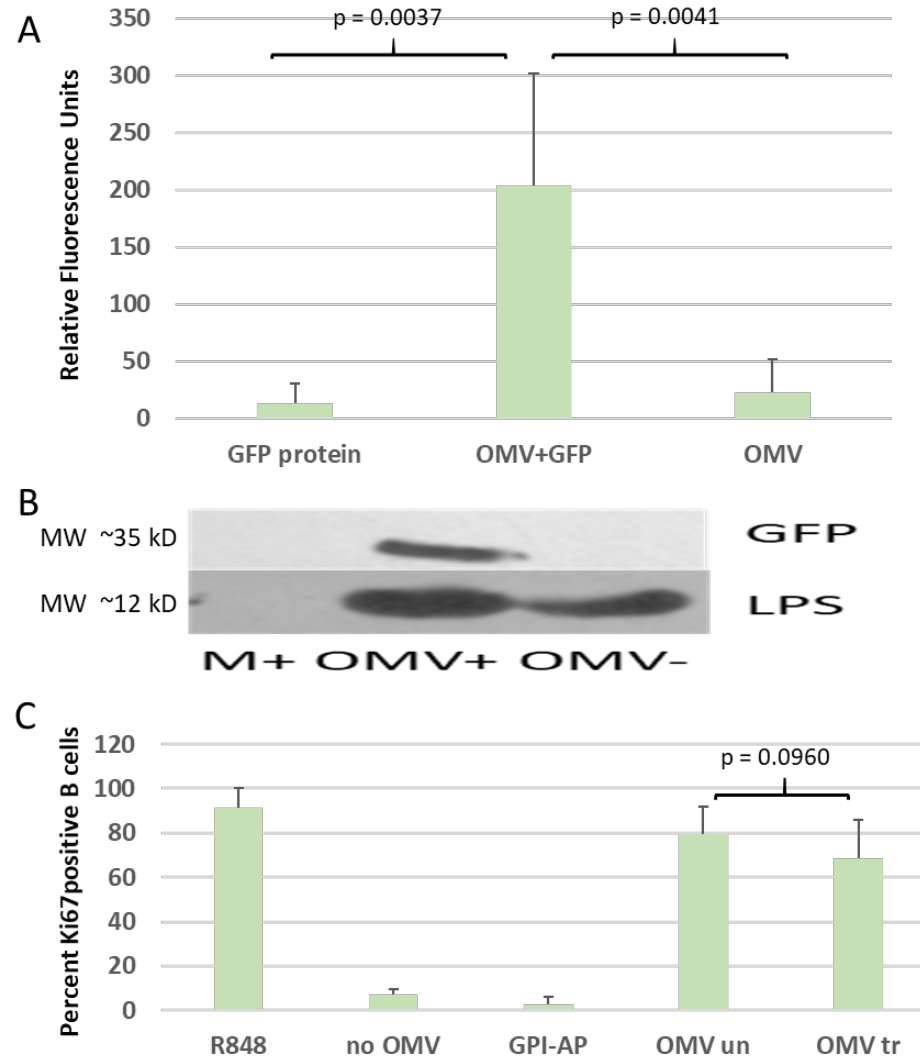
Figure 4. Molecular painting. GPI-anchored GFP only (GFP protein), OMVs only (OMV) and a mix of both (OMV + GFP) were incubated and OMV were separated from not associated material by ultracentrifugation. ( A ) Fluorometric data after molecular painting. Significantly higher fluorescence was observed in the OMV + GFP samples than in control samples containing GFP protein alone (GFP protein) and OMVs alone (OMV). Residual fluorescence is most likely due to residual GFP protein and vesicle autofluorescence. The p -values derived from t -test are indicated. ( B ) Immunoblotting for GFP and LPS. While a signal for GFP can only be found in the OMV + GFP samples, LPS is detected in all samples containing OMVs. ( C ) Flow cytometry analysis. Porcine PBMCs were incubated with OMVs to test the immune stimulatory potential of the vesicles. The B-cell proliferation marker Ki67 was used to show activation. The chemical compound R848 serves as an unspecific stimulator. In the absence of OMVs or in the presence of GPI-anchored proteins only, no significant stimulation is observed (no OMV and GPI-AP samples). OMVs show prominent B-cell stimulation, independent of whether molecular painting has been performed (compare samples OMV un and OMV tr). All error bars indicate standard deviations. N ≥ 2. The p -values are derived from t-test